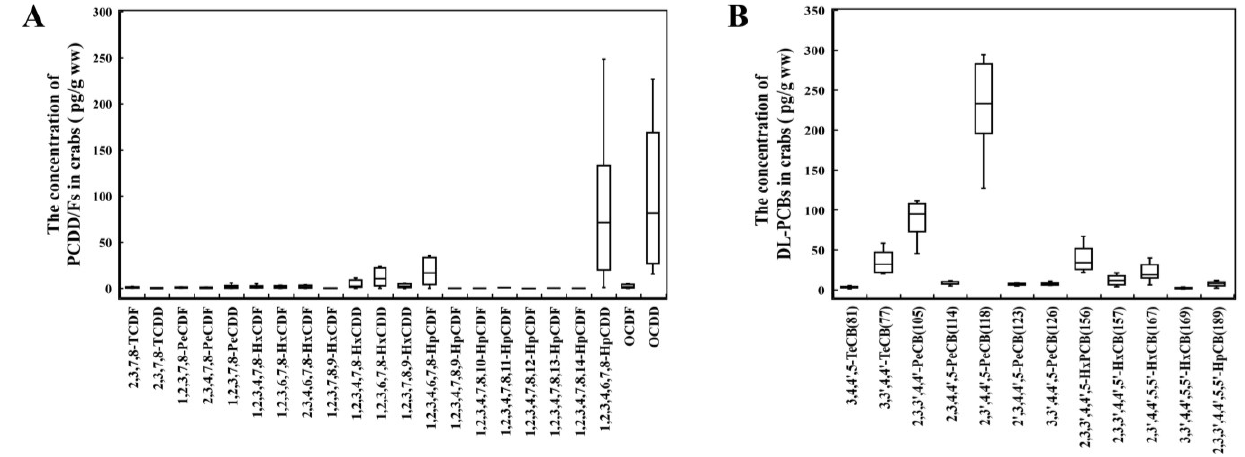
Figure 2. Concentrations of PCDD/Fs ( A ) and DL-PCBs ( B ) in farmed Chinese mitten crabs ( n = 90).